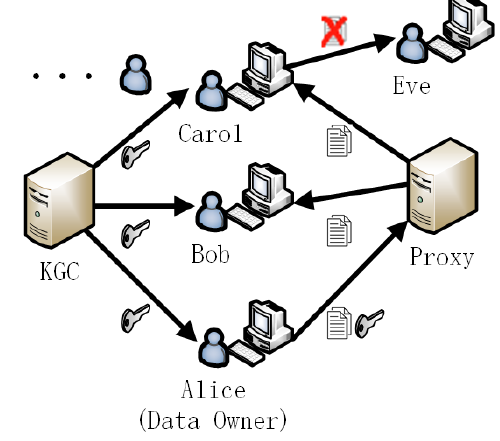
Figure 3. Data Sharing in